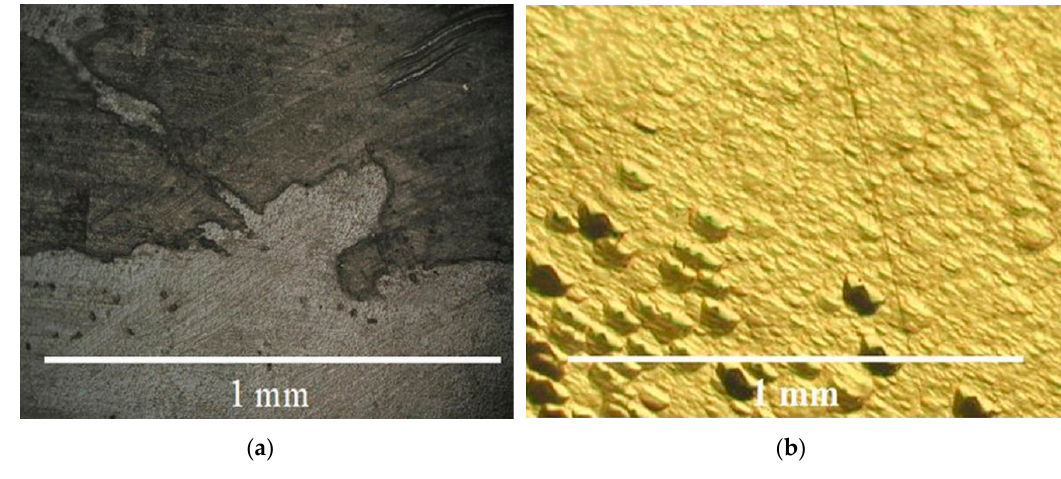
Figure 7. ( a ) Stairs and ( b ) low hillocks of the rhombohedral faces < z > and < π ’ >.